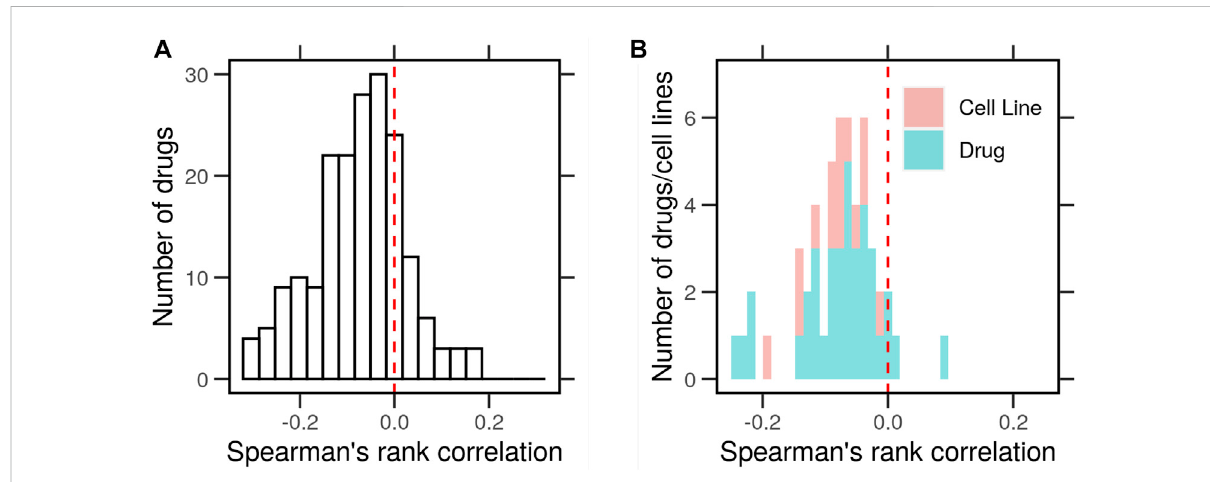
FIGURE 2 Correlation between the typical gene expression of cancer cells and the change in response to drug perturbations. Gene expression pro fi les of cancercelllines( N =46)withandwithoutdrugperturbations( N =38)wereobtainedfromthelibraryofintegratednetwork-basedcellularsignatures (LINCS).Thetypicalexpressionpro fi lesweredeterminedastheaveragebythecelllineinthecontrolconditions(DMSO).Thecharacteristicdirection (CD) of change between treated and control cells was determined. (A) Histogram of Spearman ’ s rank correlation between the average gene expression and the CD. (B) Histogram of the correlations averaged for every drug (blue) or cell line